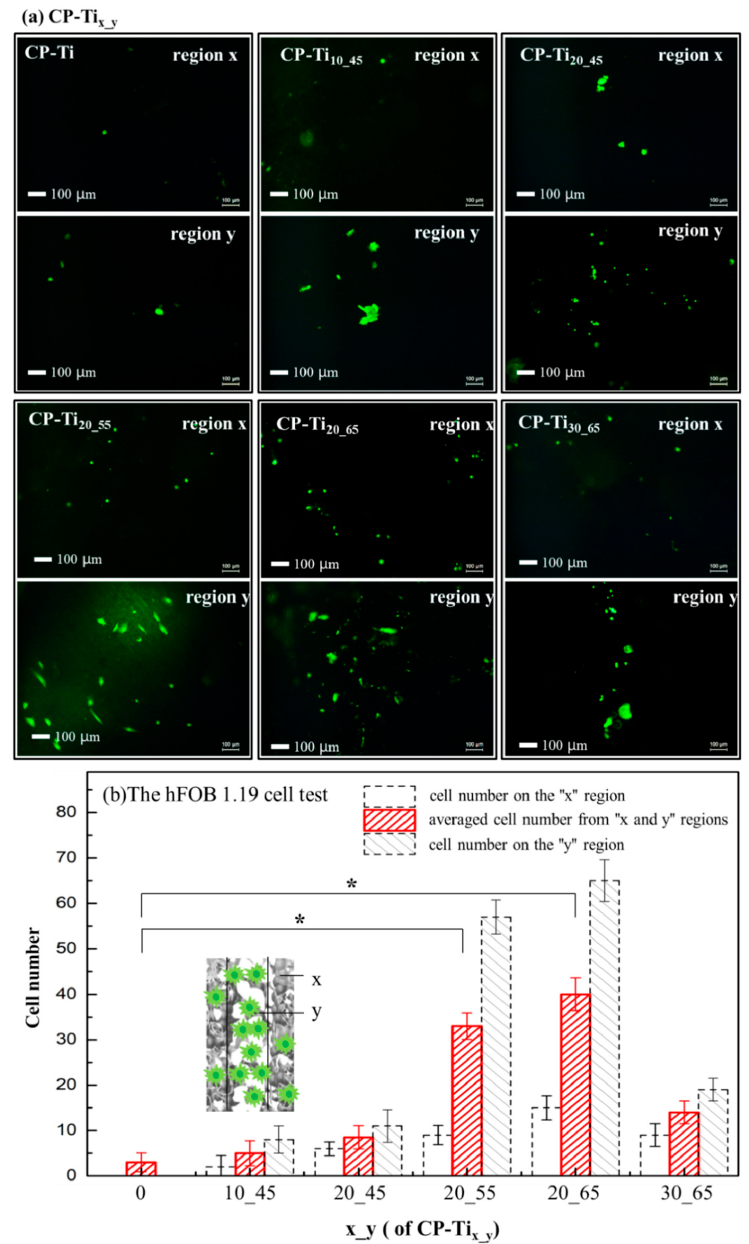
Figure 7. ( a ) The hFOB 1.19 cell viability assays, examined by taking fluorescence images after 3 days incubation upon the surfaces of CP-Ti x_y : CP-Ti, CP-Ti 10_45 , CP-Ti 20_45 , CP-Ti 20_55 , CP-Ti 20_65 , and CP-Ti 30_65 . Cell numbers were counted on the regions of x (low porosity), y (high porosity), and around the border (i.e., the dotted lines shown in Figure 2). ( b ) By averaging the cell numbers from the regions x and y, the relation between cell numbers and the overall surfaces were demonstrated. It shows that cell viability on the surfaces of CP-Ti 20_55 and CP-Ti 20_65 significantly increases. *: p < 0.05 had statistical di ff